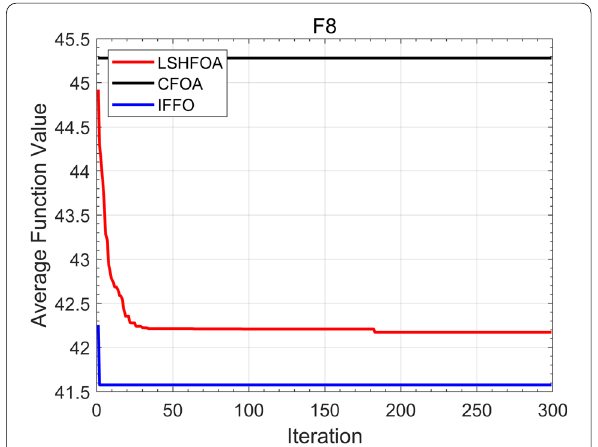
Fig. 14 Performance of the algorithm under F8 function